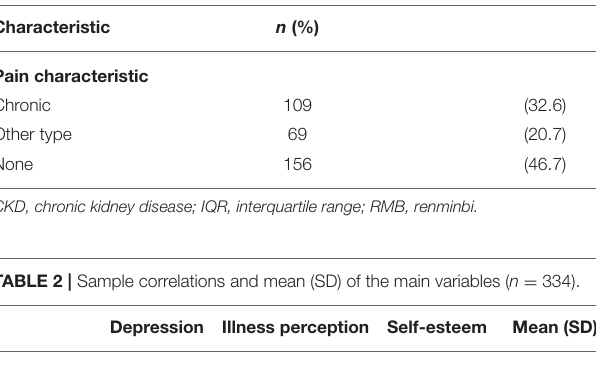
TABLE 1 | Demographic and clinical data of CKD patients.